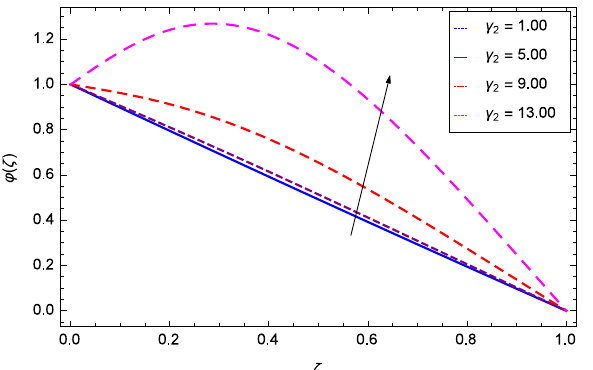
Figure 27. Analysis through temperature difference parameter γ 2 and nanoparticles concentration ϕ ( ζ